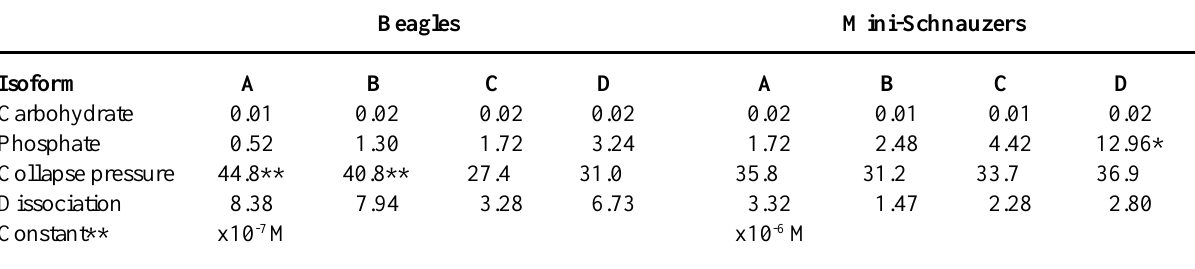
Table 4 – Chemical composition and physical properties of 4